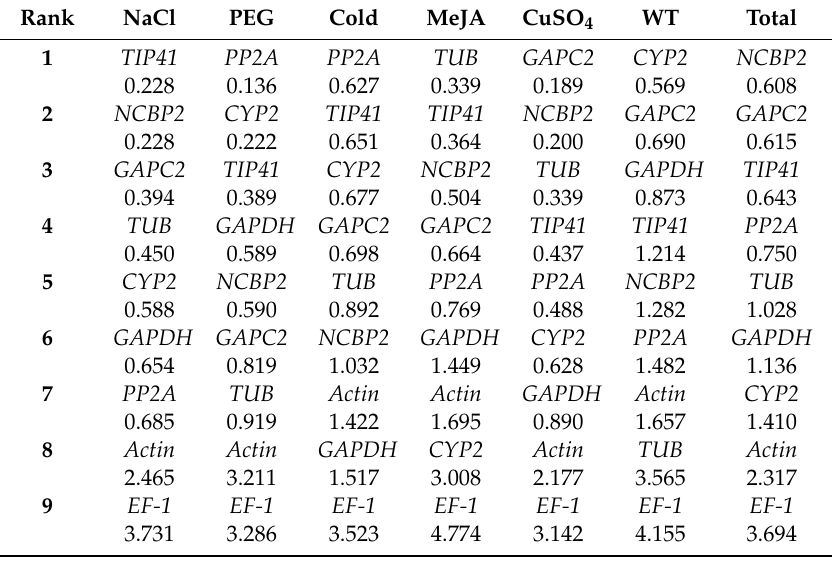
Table 3. Expression stability rank of nine candidate genes by NormFinder